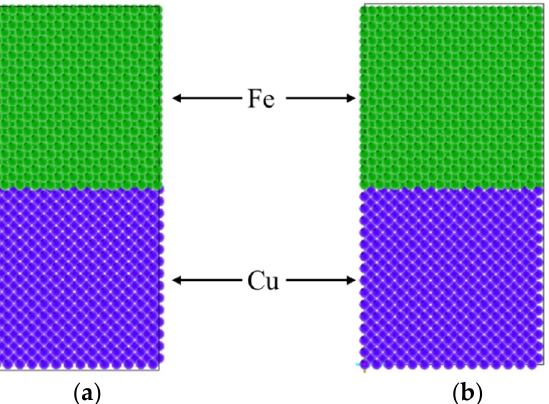
Figure 10. The structure of the molecular dynamic models: ( a ) BCC Fe + FCC Cu; ( b ) FCC Fe + FCC Cu.